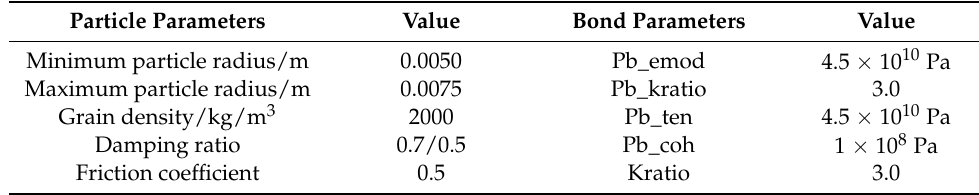
Table 3. Table of mesoscopic parameters of filling